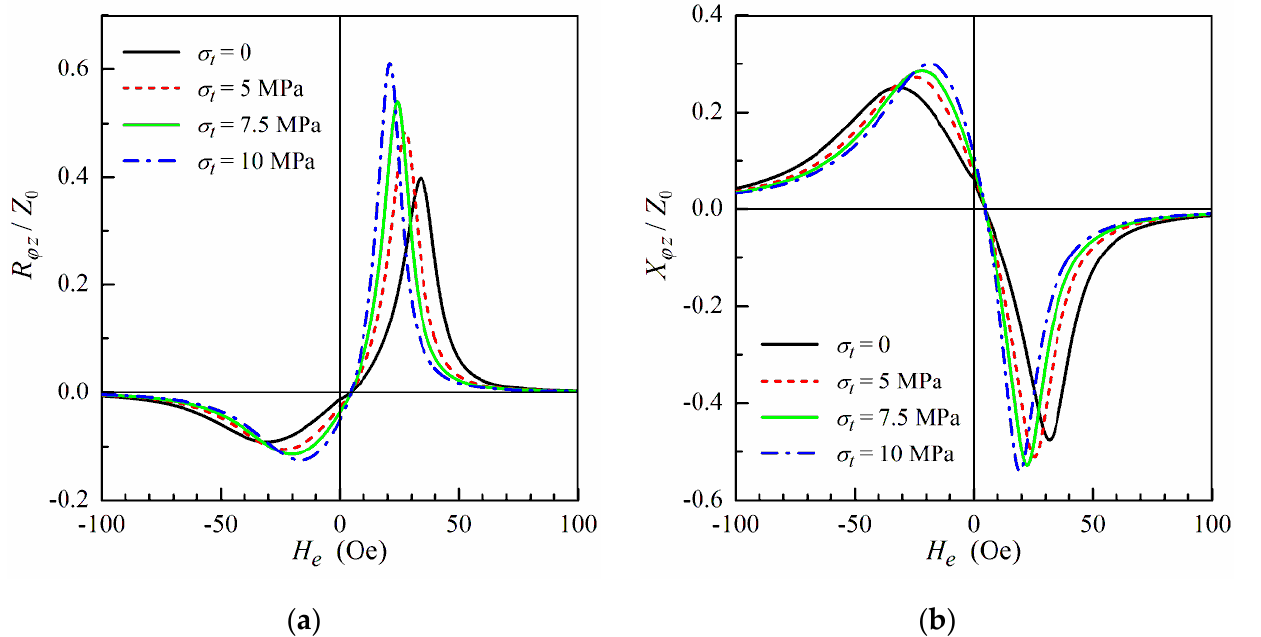
Figure 6. ( a ) The real part R ϕ z and ( b ) the imaginary part X ϕ z of the ODMI as a function of the external field H e at f = 100 MHz and I b = 30 mA for different values of the tensile stress σ t . Magnetostriction coefficient λ s = 40 × 10 − 6 , other parameters used for calculations are the same as in Figure 3.